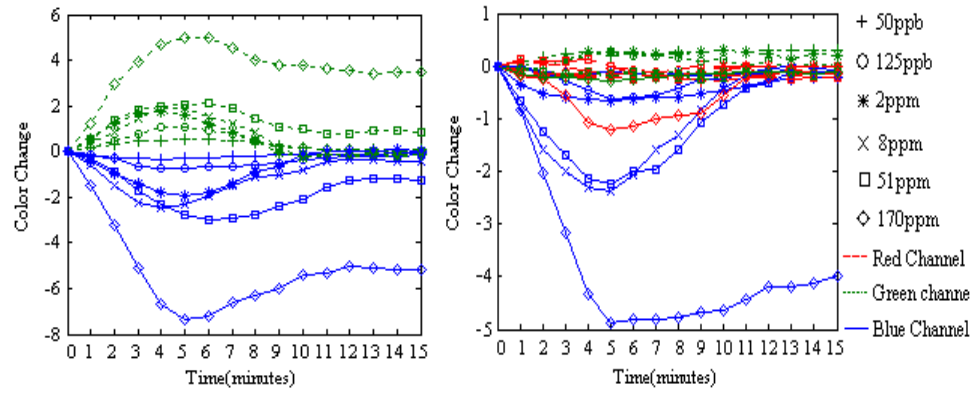
Figure 6. Representative responses for dye H2OEP (left) and dye CoTPP (right), showing the magnitudes of red, green and blue color changes over the course of 5 minutes exposure to the six TMA concentrations and followed by 10 minutes exposure to N reproducibility test. The response curves on the red channel for H2OEP gather in the zero neighboring area with a biggest magnitude of